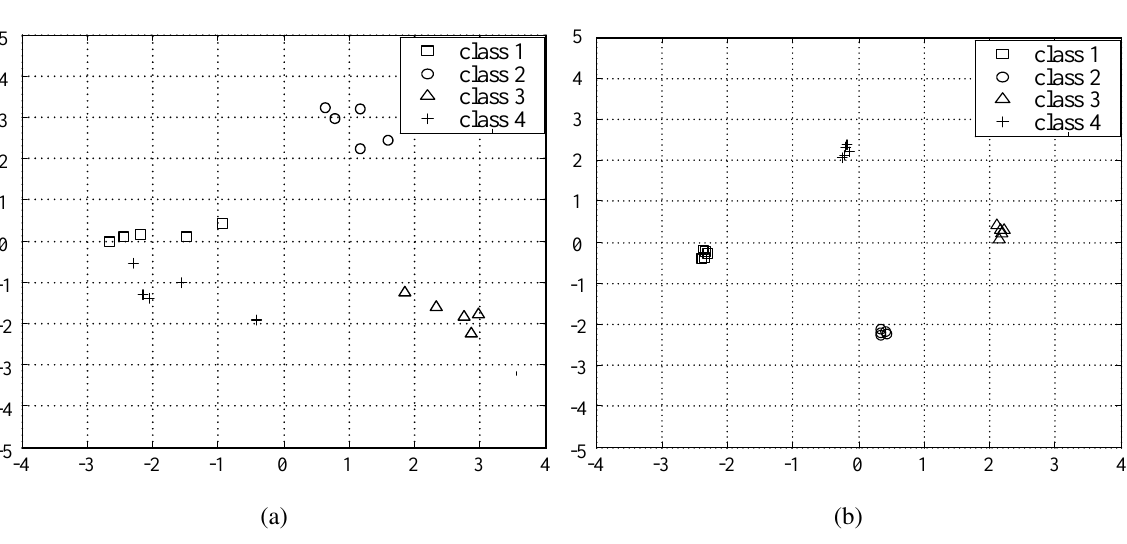
in two principal component axes. (a) original s = s